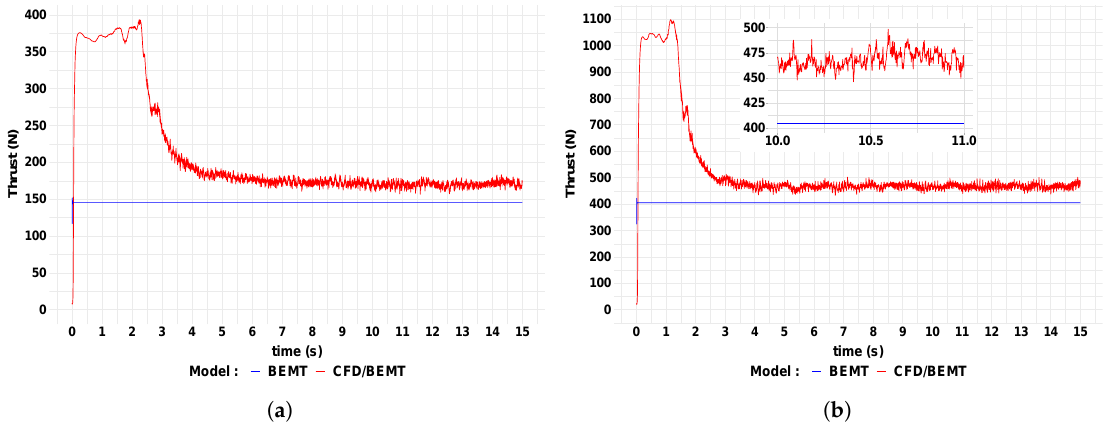
Figure 6. Thrust for ( a ) Uo = 0.6 m/s and ( b ) Uo = 1.0